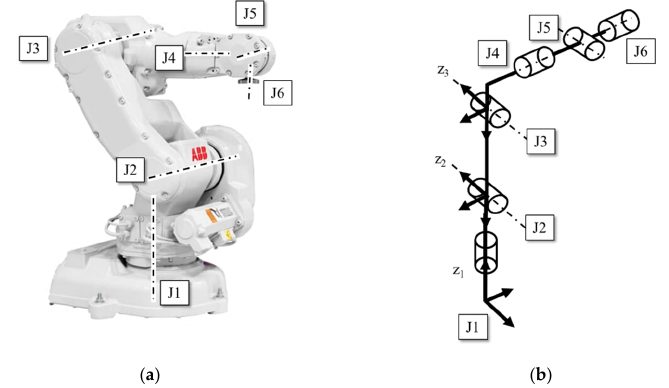
Figure 4. The simulated case study: IRB140 robot ( a ) and D-H representation ( b ).